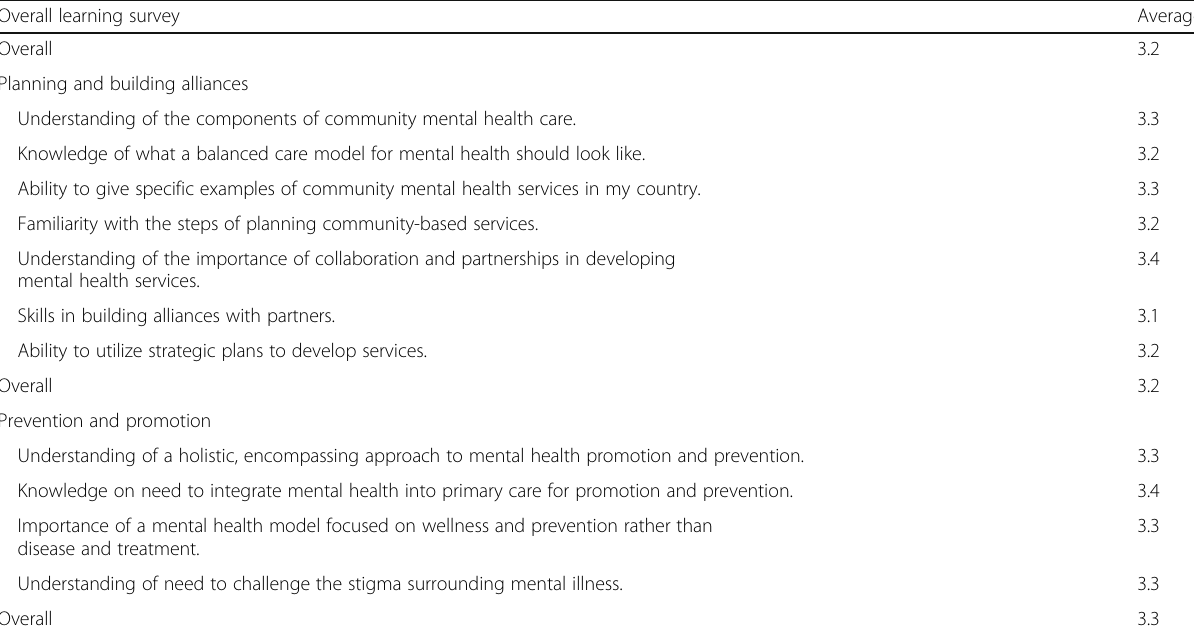
Table 3 Overall learning survey